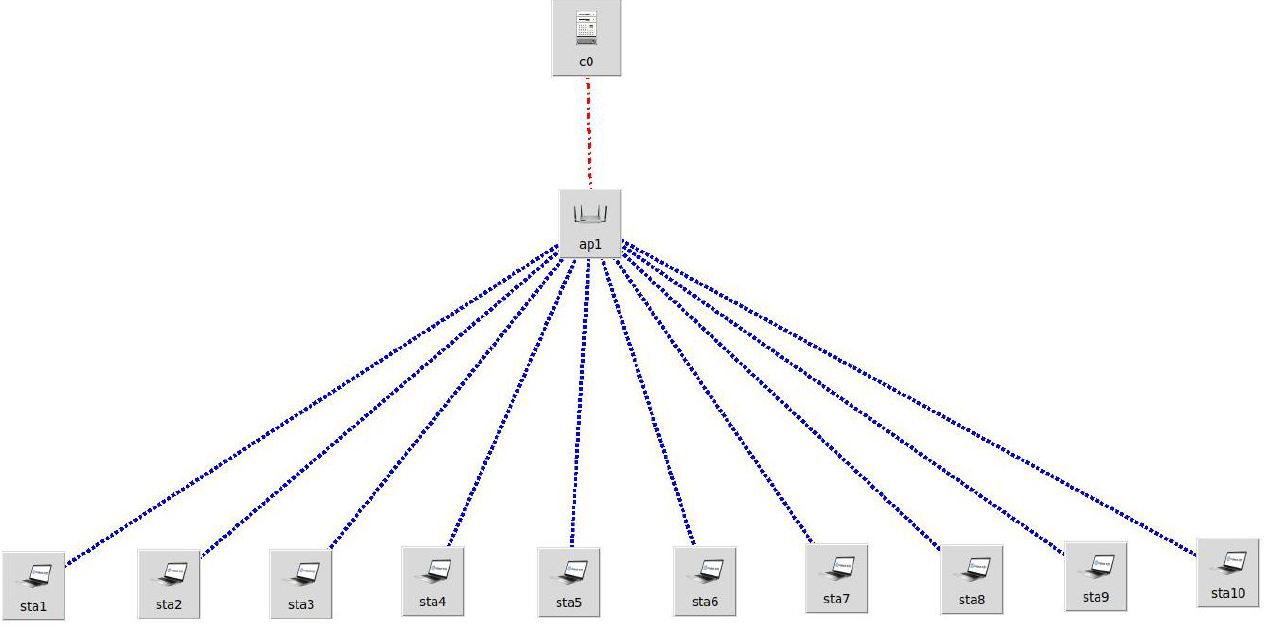
Figure 3. Simple topology.